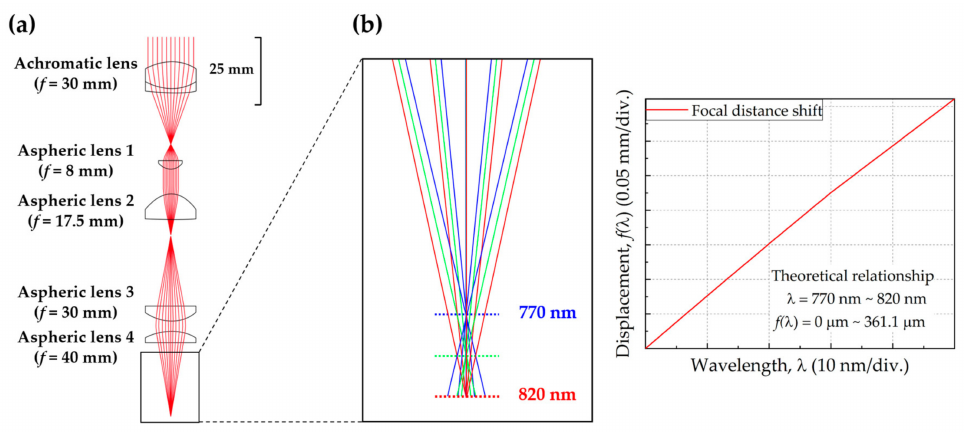
Figure 2. ( a ) Optical design of the chromatic dispersive lens array. ( b ) The relationship between the displacement and the wavelength of light corresponding to the chromatic dispersion simulation of the designed probe obtained using CODE